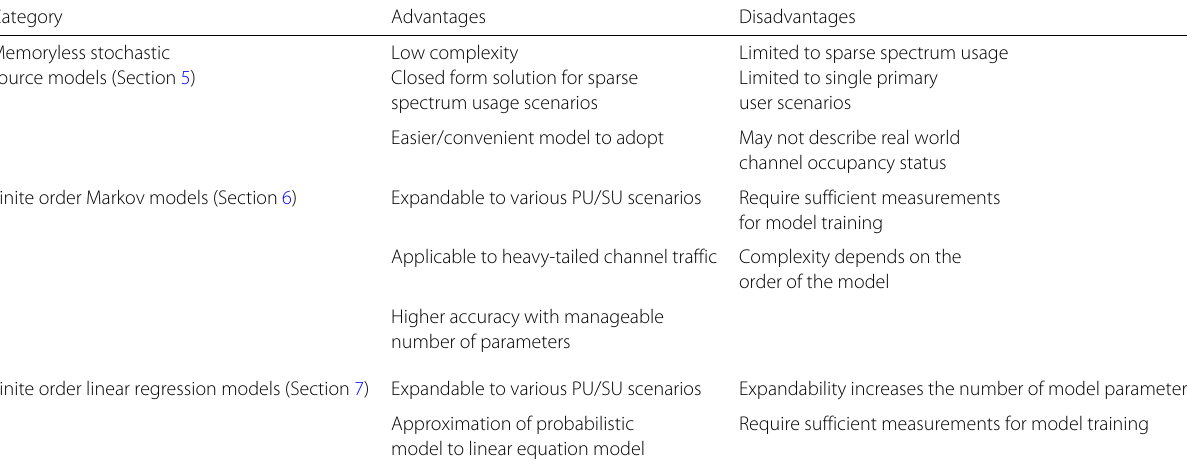
Table 2 Comparison of spectrum prediction categories